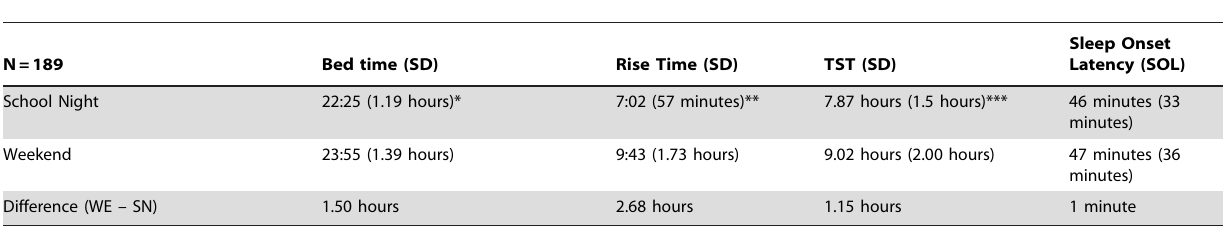
Table 2. Self reported total sleep time, bed times, and rise times for Afghan UASC on school nights and weekends and significant differences between the two